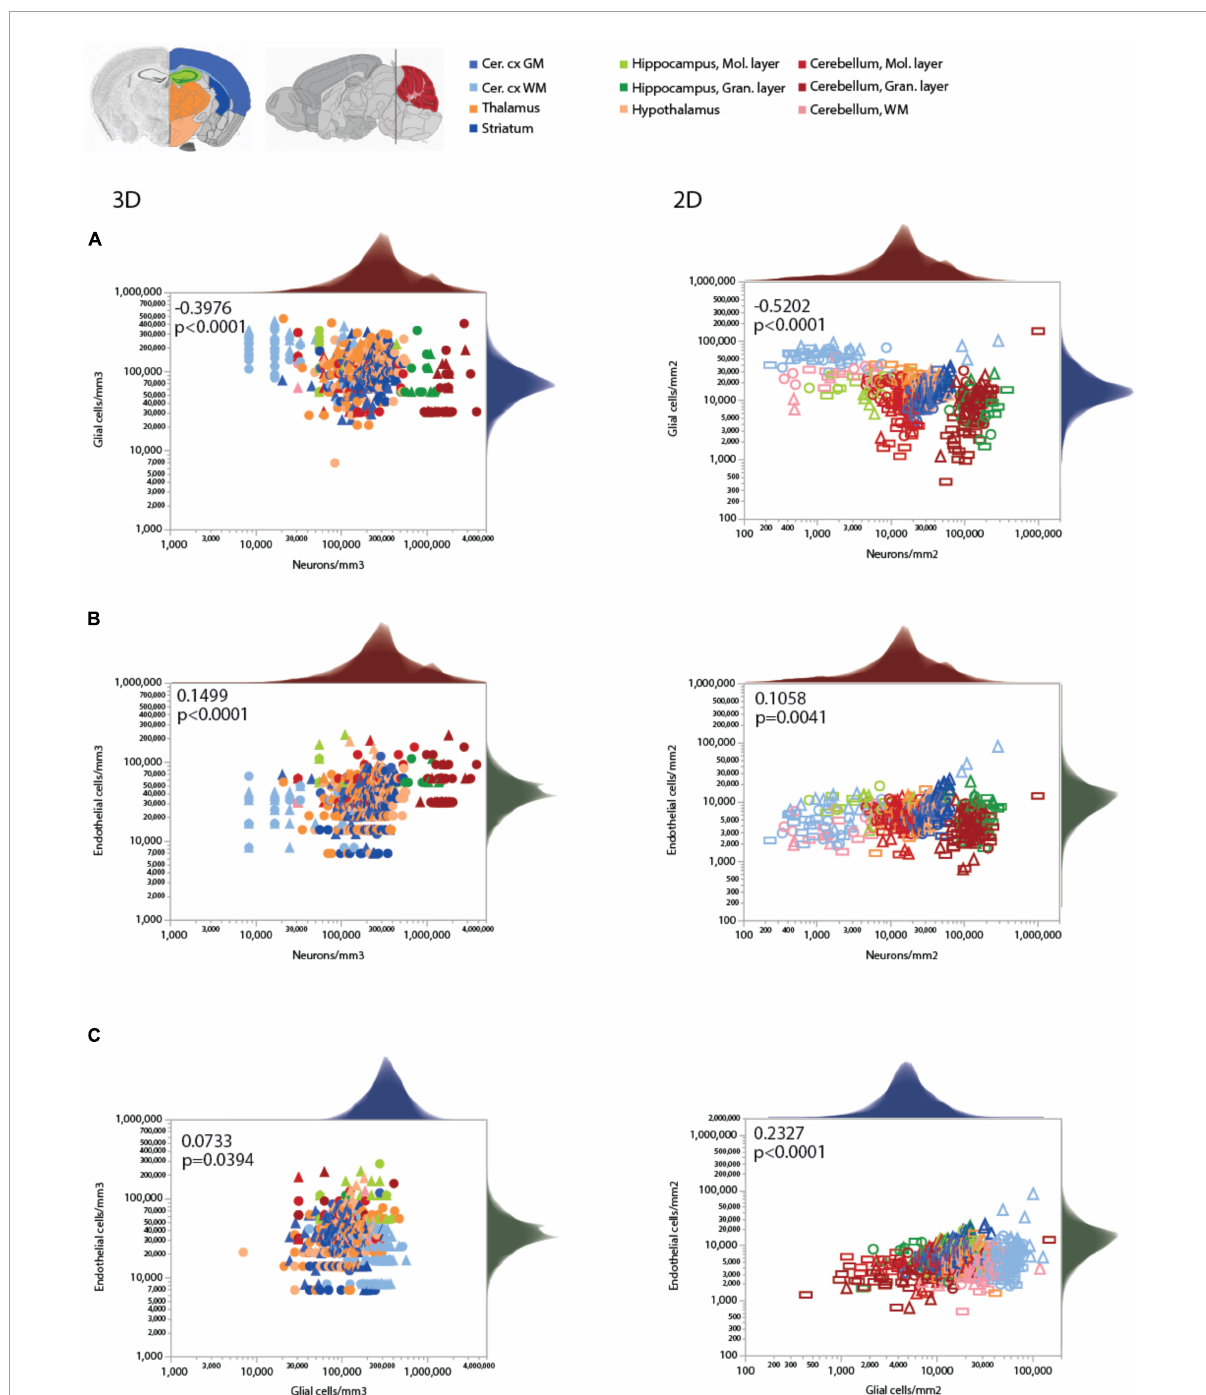
FIGURE5 Local densities of different cell types vary concertedly only within some brain structures. Each plot is accompanied by the respective distribution histograms aligned with the X and Y axes. Spearman correlation coefficients and p -values across all structures and sites are indicated in each graph. (A) Glial cell densities span just over one order of magnitude across structures, while neuronal cell densities span two orders of magnitude. While the correlation across all data points is significant and negative in both 3D and 2D datasets, analysis at that level ignores obvious differences across structures (see Table 6 ). (B) Similarly, endothelial cell densities are concentrated within one order of magnitude across structures and sites, and are similar across structures with very different neuronal densities. Still, local endothelial and neuronal cell densities are significantly and positively correlated within the cortical gray matter, the thalamus, and the striatum (see Table 6 ). (C) Glial and endothelial cell densities, which vary little across sites and structures in comparison to neuronal densities, are not strongly correlated across brain structures, and weakly correlated within some (see Table 6 ). All graphs are shown with similar X and Y scales for